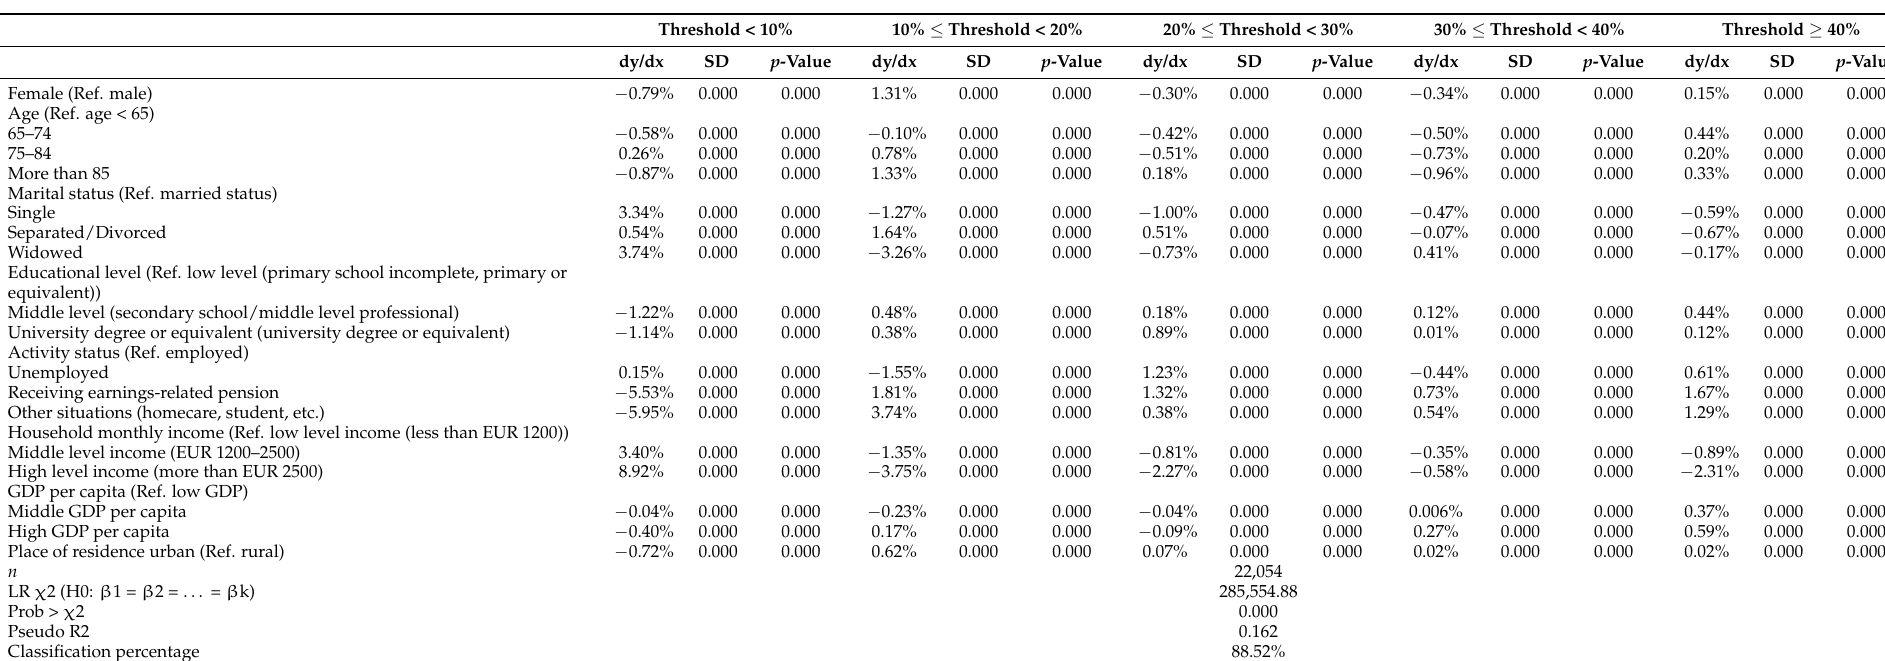
Table 7. Marginal effects of the sociodemographic factors of households in Spain associated with financial catastrophism derived from out-of-pocket payments in health in Spain. Year 2015.